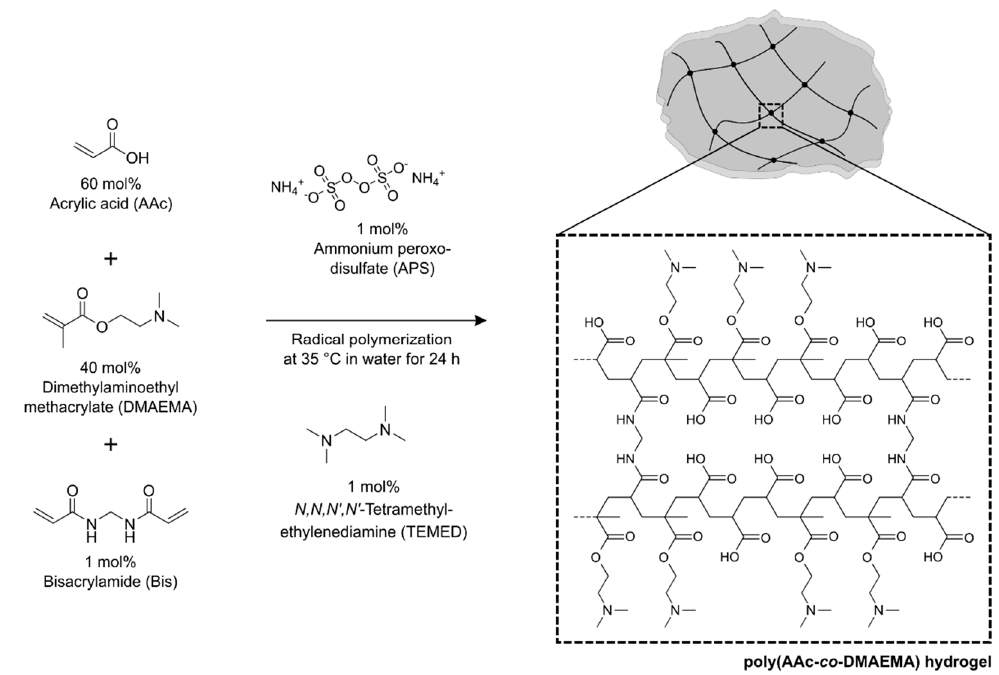
Figure 1. Synthesis of poly acrylic acid ‐ co ‐ dimethylaminoethyl methacrylate hydrogels.